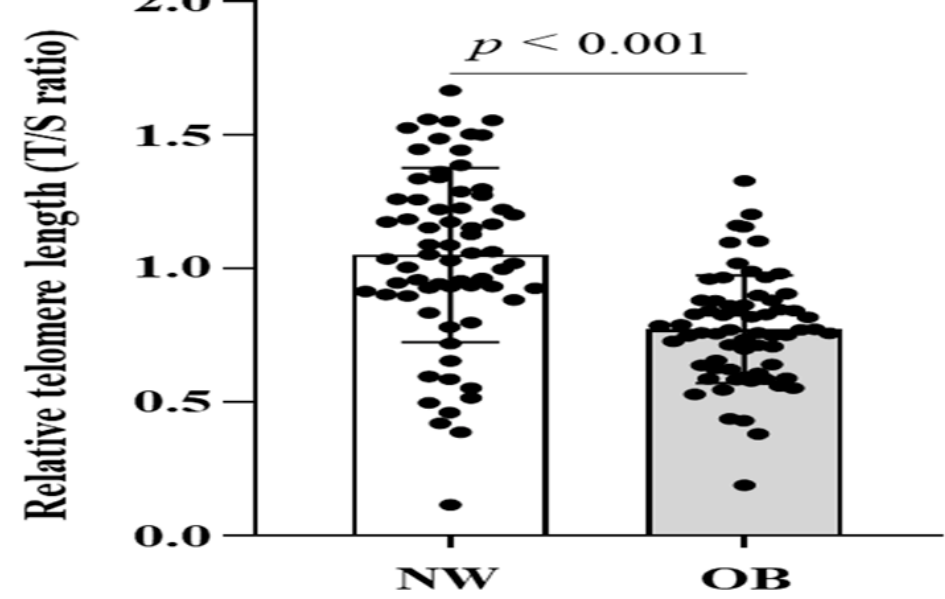
Figure 1. The blood leukocyte relative telomere length (T/S ratio) in participants with NW ( n = 68) and OB ( n = 66). The p -value was measured by independent t -test. Abbreviation: NW, normal weight; OB, obesity.